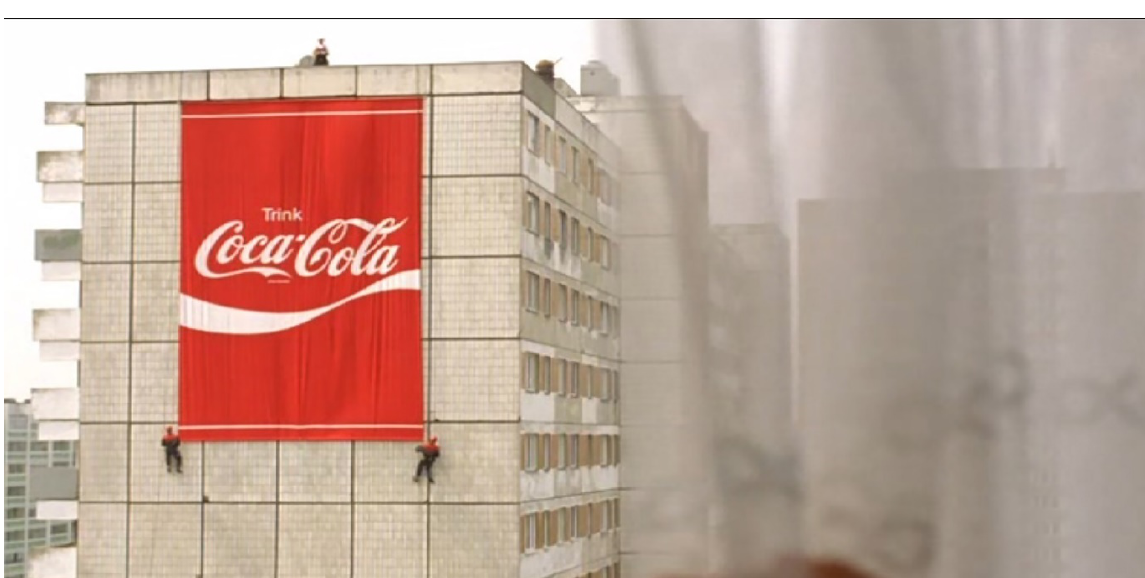
Figure 4 The rise of the Coca Cola advertisement from the Mother’s